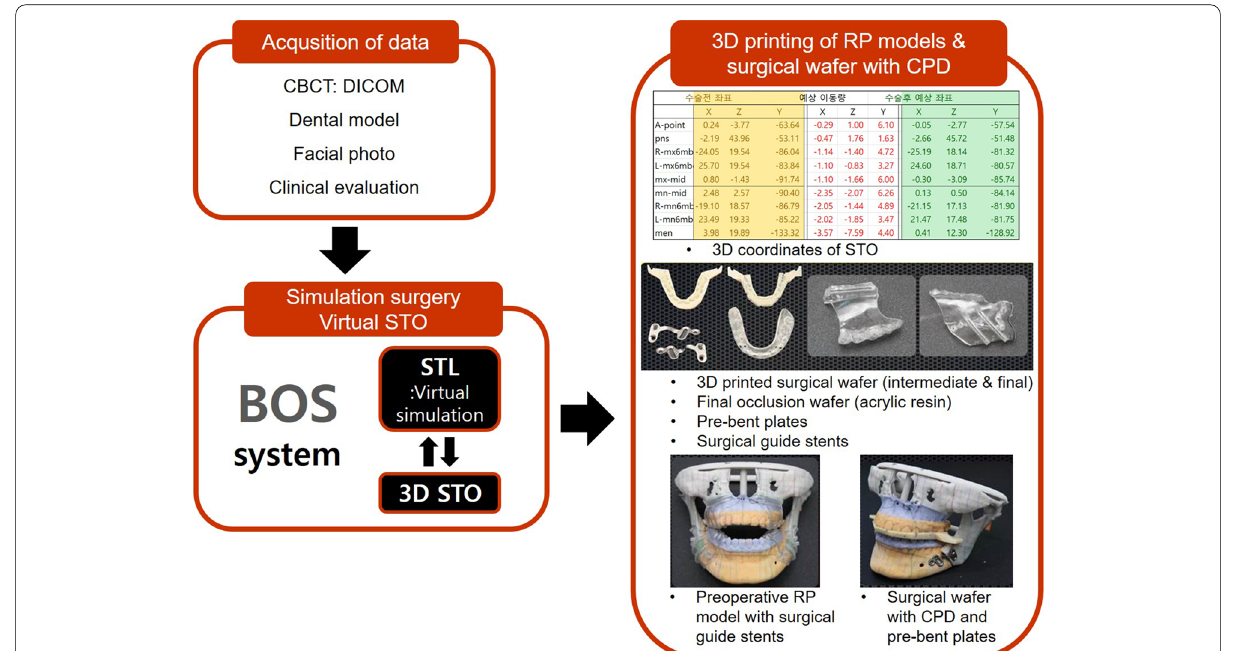
Fig. 1 Preparation process for orthognathic surgery using BOS